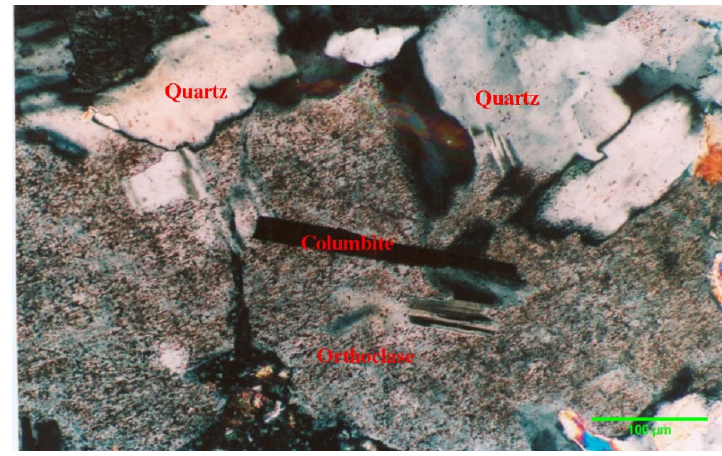
Figure 8. Columnar columbite (black) included in orthoclase.